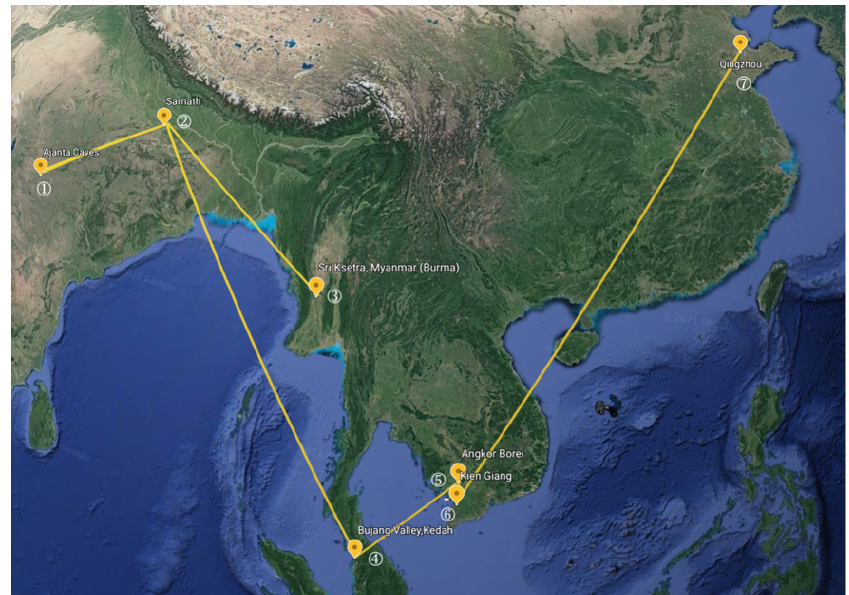
Figure 9. The schematic diagram of the transmission route of standing Buddha statues with diaphanous robe covering only the left shoulder (type C). ① Ajanta Caves, India; ② Sarnath, India; ③ Sri Ksetre, Myanmar; ④ Bujang Valley, Kedah, Malay Peninsula; ⑤ Vat Romlok Site, Angkor Borei, Cambodia; ⑥ Nen Chua, Kien Giang Province, Vietnam; ⑦ Longxing Temple Site, Qingzhou, Shandong Peninsula, China.